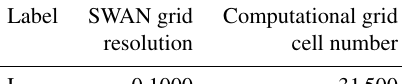
Table 1. SWAN grid resolution, grid cell numbers and reference labels.